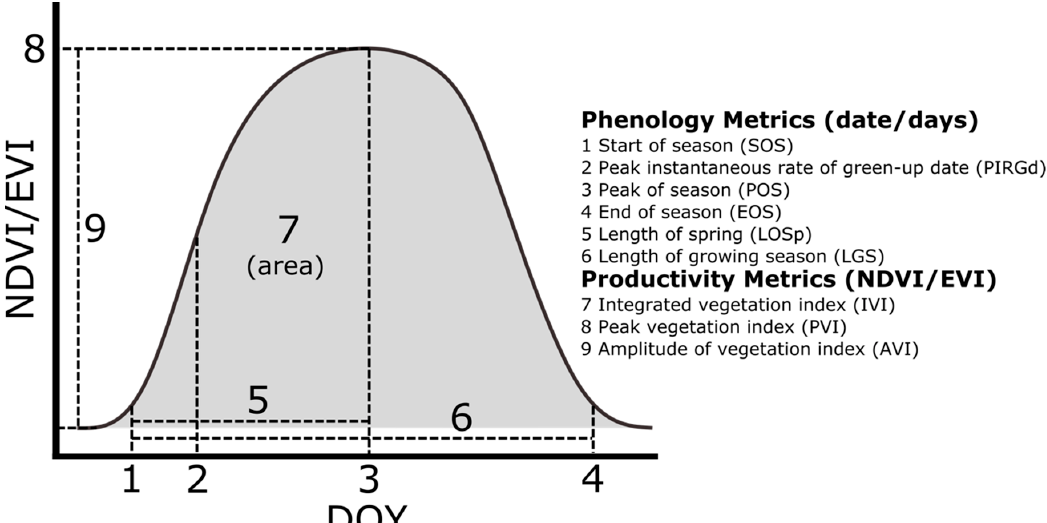
Figure 2. Six phenology and three productivity metrics shown through an example growing season by day of year (DOY). Note that these metrics are described through values of Normalized Difference Vegetation Index (NDVI)/Enhanced Vegetation Index (EVI) but certain datasets may produce metrics using other methods/algorithms.